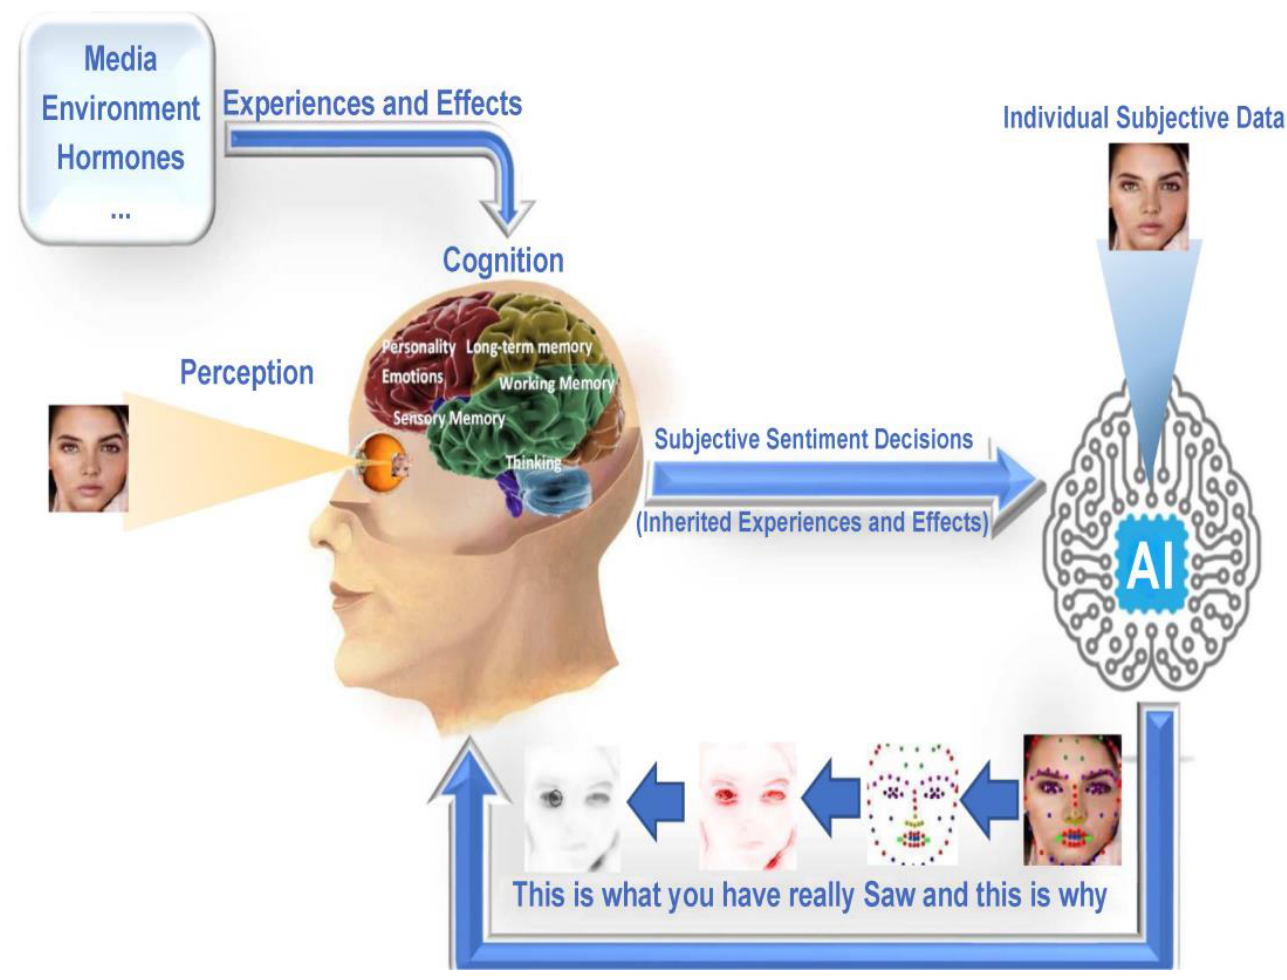
Figure 1. An illustration of research methodology.